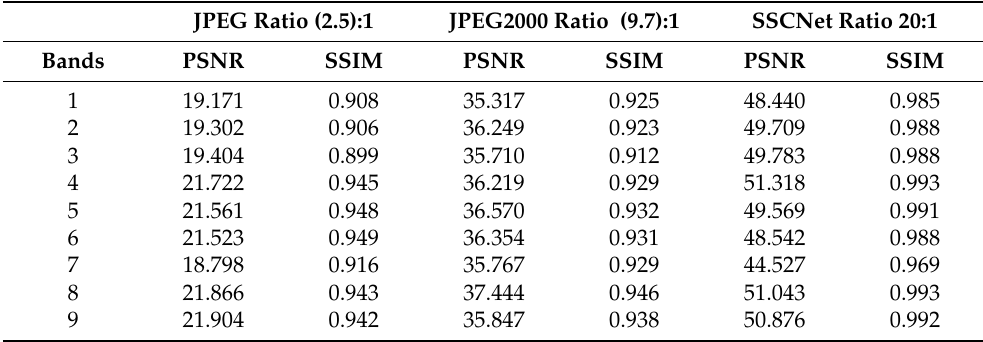
Figure 5. Comparison using the compression ratio 20:1 for SSCNet and (9.7):1 for JPEG2000 with a data type 16 bits on the original source tile ( a , d ) using JPEG2000 algorithm applied over all bands in ( b , e ) and SSCNet signal reconstructed in ( c , f ). We show only bands 1 and 2. Table 4. Benchmark comparison between two classical compressor algorithms (JPEG, JPEG2000) and the SSCNet AutoEncoder based over the Lombardia sentinel